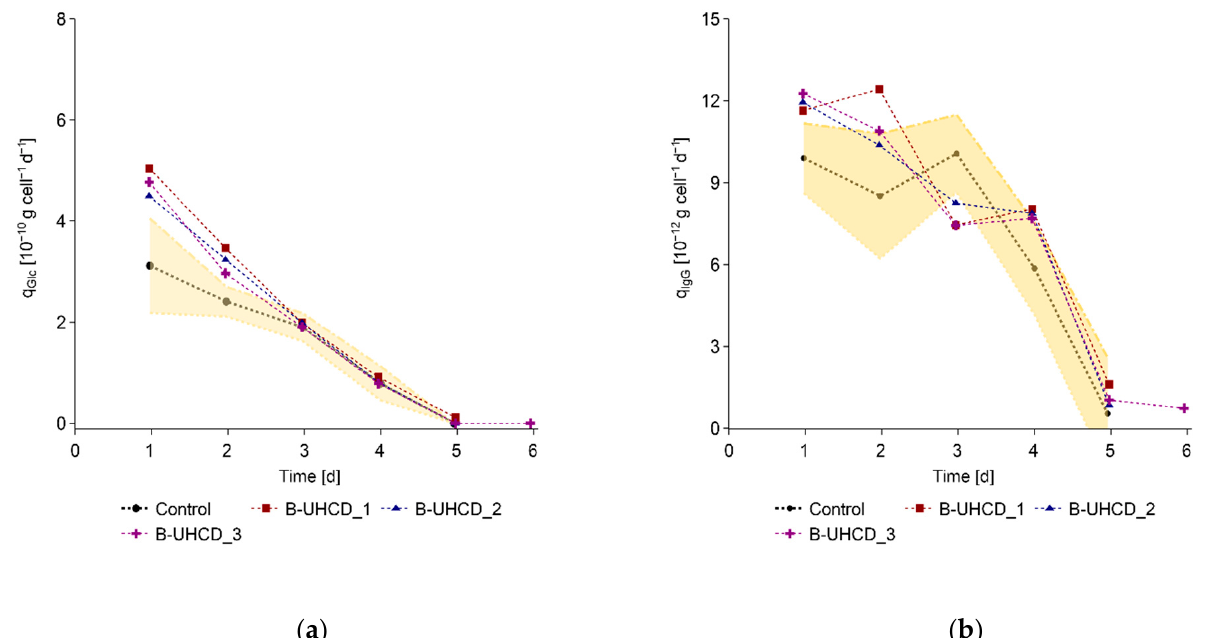
Figure A4. Course of ( a ) glucose consumption rate, and ( b ) IgG production rate during the batch experiments inoculated directly from the UHCD-WCB (nomenclature: B = Batch, UHCD = inoculated from UHCD-WCB). Control: batch experiments inoculated directly from cryovials containing lower VCDs (15 × 10 6 cells mL − 1 , n = 3).